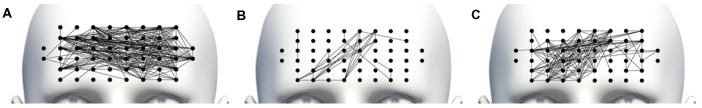
Channel correlation density map for (A) HC, (B) normal OI (NOI) and (C) abnormal OI (AOI) subjects. A line was drawn connecting channel pairs whose average correlation coefficient was greater than or equal to 0.8.